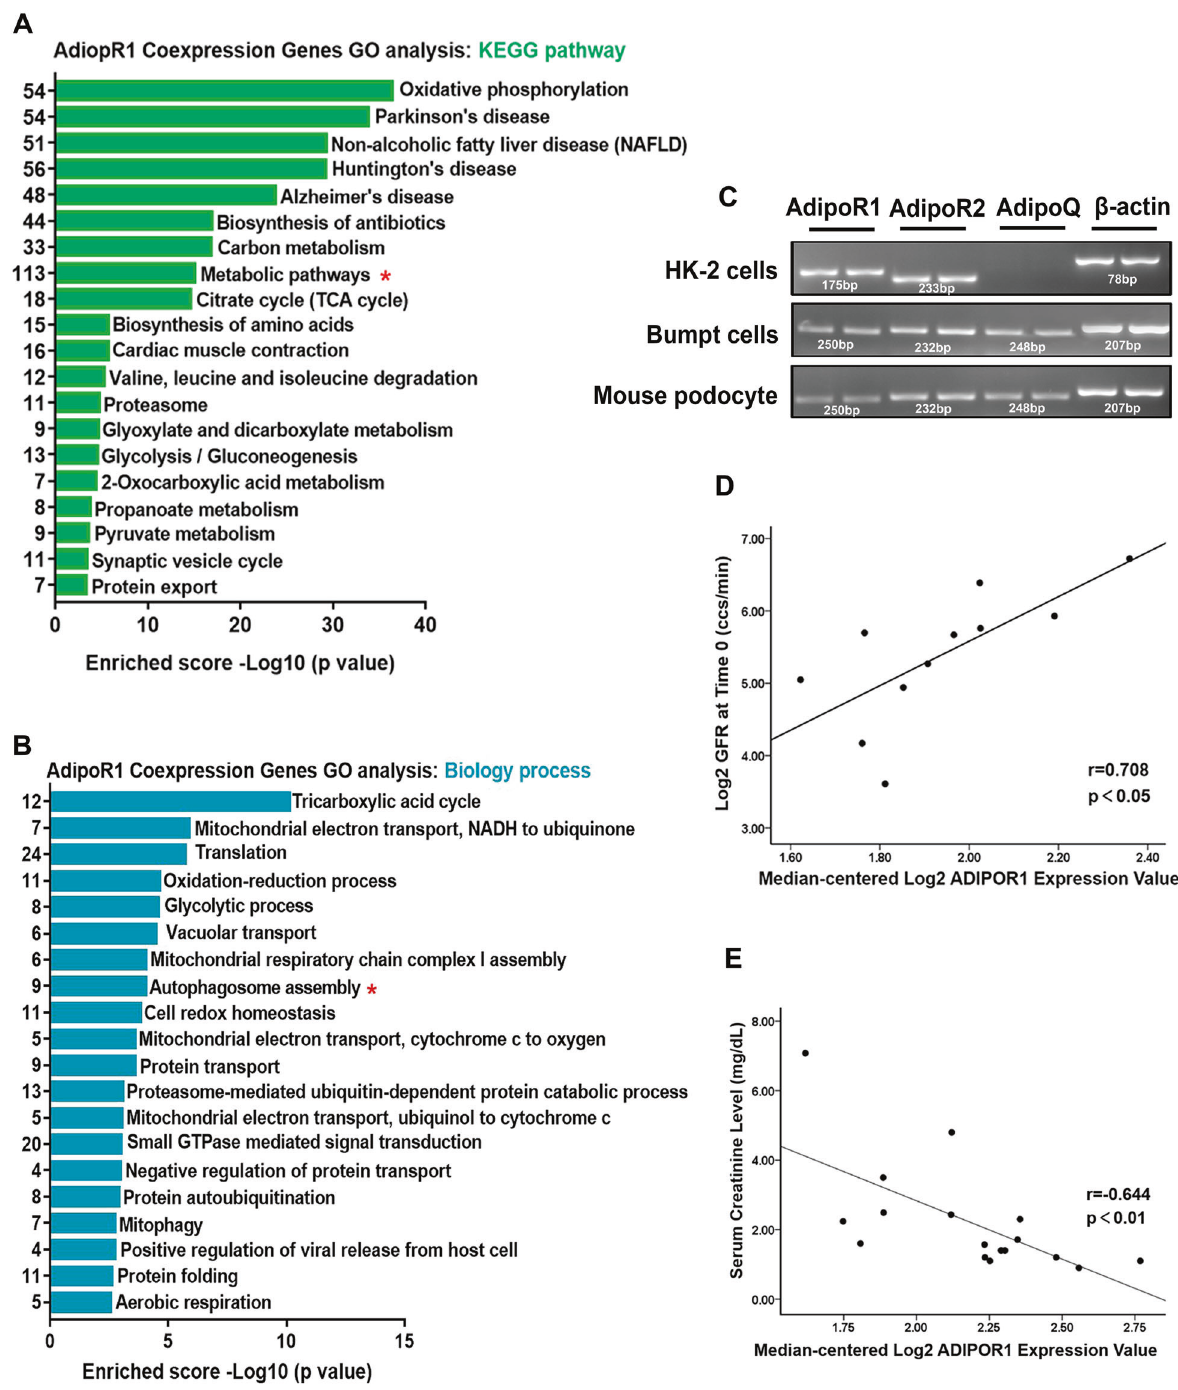
Fig. 2 Analysis of AdipoR1 genes. GO analysis of genes coexpressed with AdipoR1 (positive correlation coef fi cient ≥ 0.6) according to KEGG pathway ( A ) and Biology process ( B ). Detection of AdipoR1 , AdipoR2 and AdipoQ by PCR ampli fi cation of DNA from HK-2 cells, BUMPT cells and mouse podocytes ( C ). Correlation of AdipoR1 expression and GFR ( D ) and serum creatinine level ( E ) in patients with DN and control individuals from the Nephroseq database. Values are the mean ± SD; r : correlation coef fi cient; * p < 0.05 versus determined by the abundant ADRP expression and the absence of GAPDH (Fig. 4E). Fibronectin (FN)and Collagen I were reduced by AdipoRon treatment (Fig. 4F, G). Protein alterations in ADRP, sterol regulatory element binding protein- 1 (SREBP-1), FN and Collagen I were further con fi rmed by WB analysis (Fig. 4H, I).